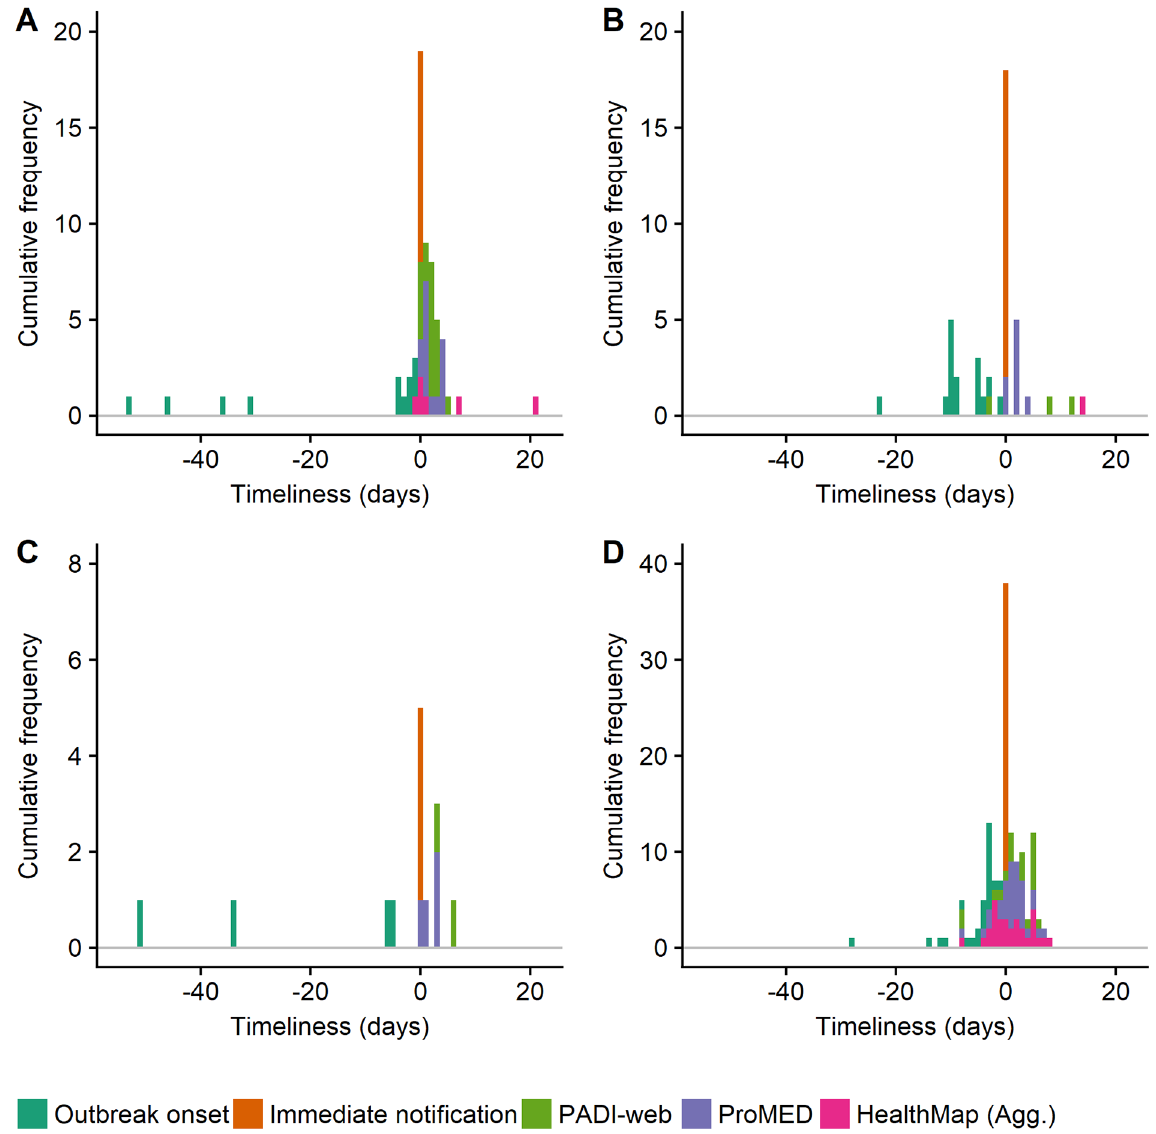
Fig 7. A. African swine fever, B. Foot-and-mouth disease, C. Bluetongue, D. Avian influenza. The figures show the lag in days from the onset of a primary outbreak, its immediate notification to the World Organisation for Animal Health (OIE) and its detection by PADI-web, ProMED and HealthMap (Agg.) from January to June 2016. Zero-day represents the date of immediate notification. The figures show the range from 55 days before to 25 days after immediate notification.